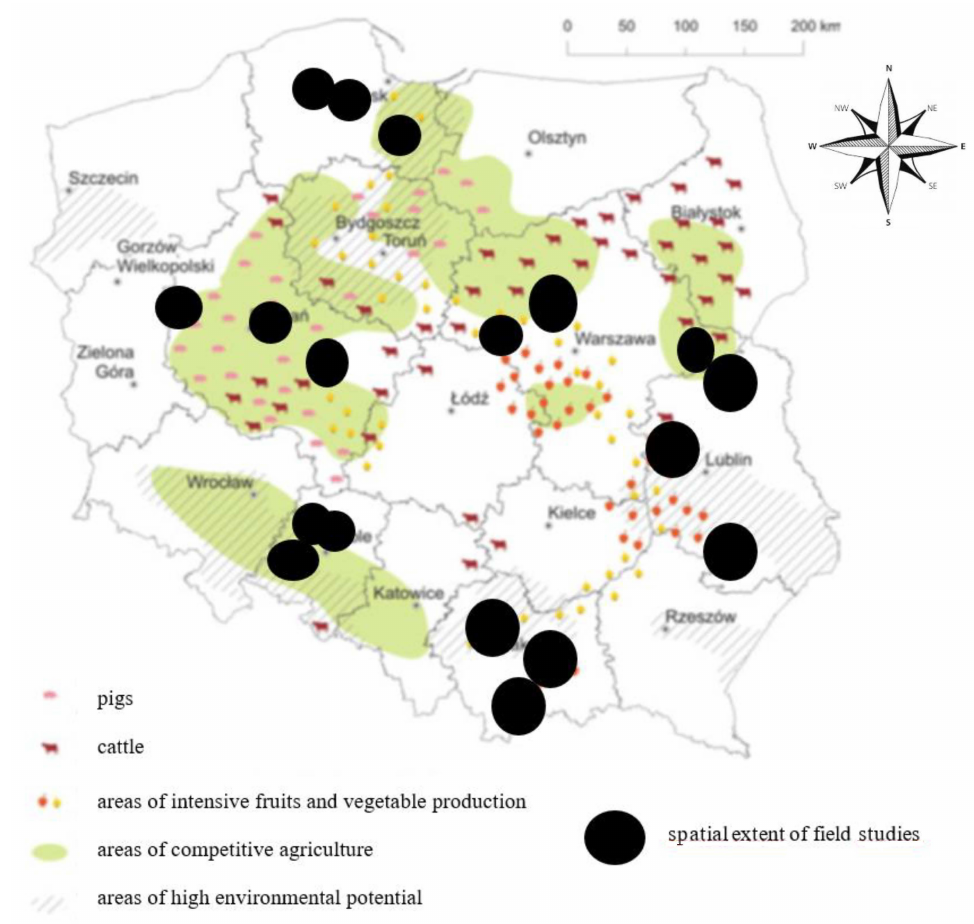
Figure 1. Main food producing areas in Poland and spatial extent of field studies